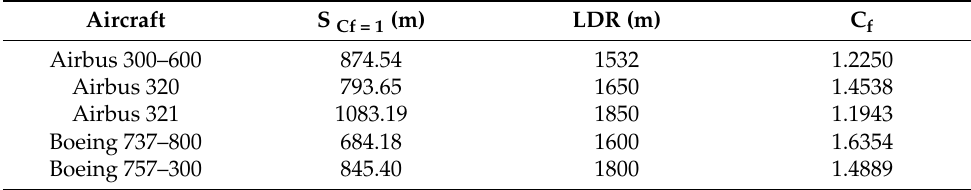
Table 7. Assessed calibration factors for each aircraft.